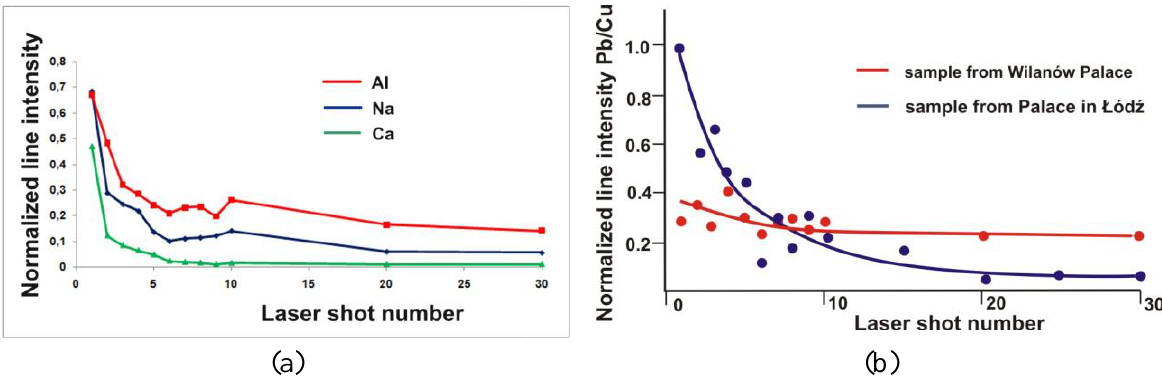
Figure 8. Results of in-depth LIBS analyses of elements in the copper roofing deposit: